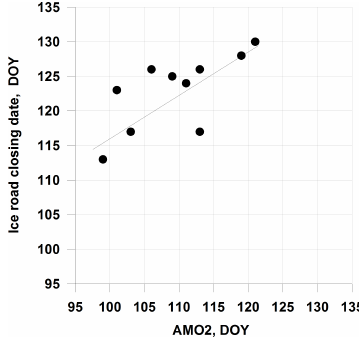
Figure 13. Relation between the altimetric breakup onset dates (AMO2) and those observed for the Salekhard ice road clo- sure dates expressed in the day of the year